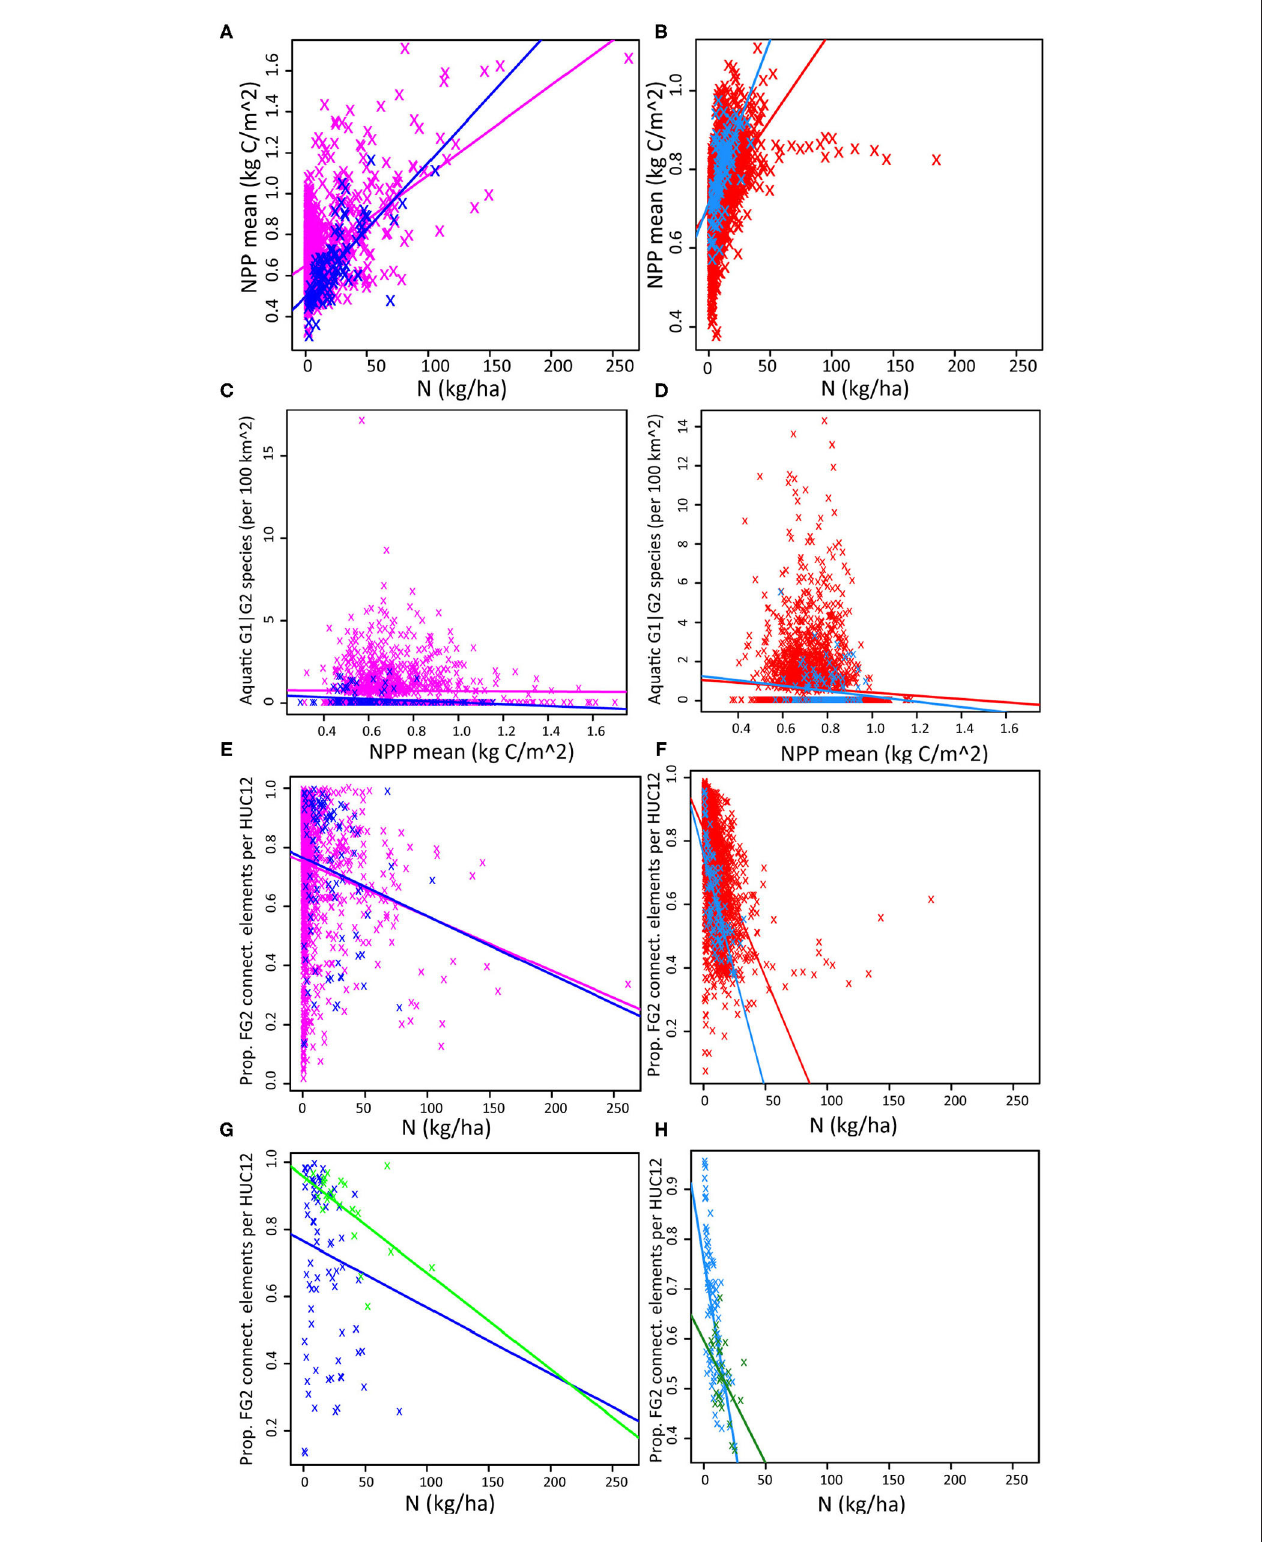
FIGURE 10 | Pairwise comparisons of selected ecosystem service indicators ( Supplementary Material 3 ). (A) Provisioning vs. Regulating: Mean NPP, 2014–2018 (kgC/m 2 ) vs. Agricultural N runoff (kg/ha 1 ), in CPEco (magenta, n = 1,219), and FL-HUC8s (blue, n = 94) study areas. (B) Provisioning vs. Regulating: Mean